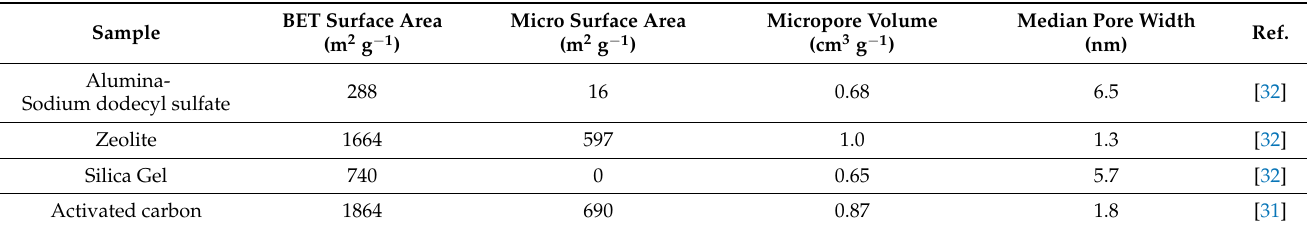
Table 1. Comparison of specific surface areas, micro surface areas, micropore volumes, and pore sizes of the templated carbons and activated carbon determined from the N 2